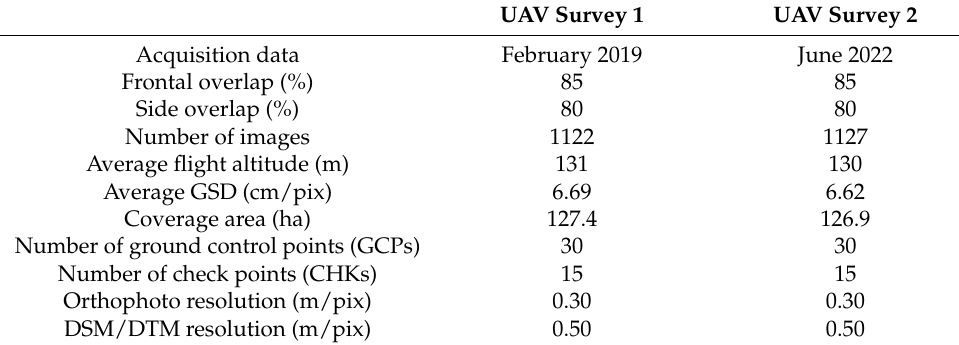
Table 1. Data on the UAV surveys’